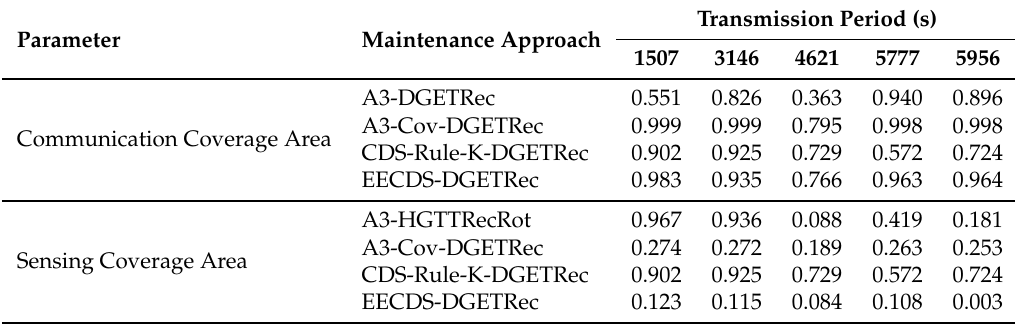
Table 6. Comparison of performances in terms of communication and sensing coverage areas.